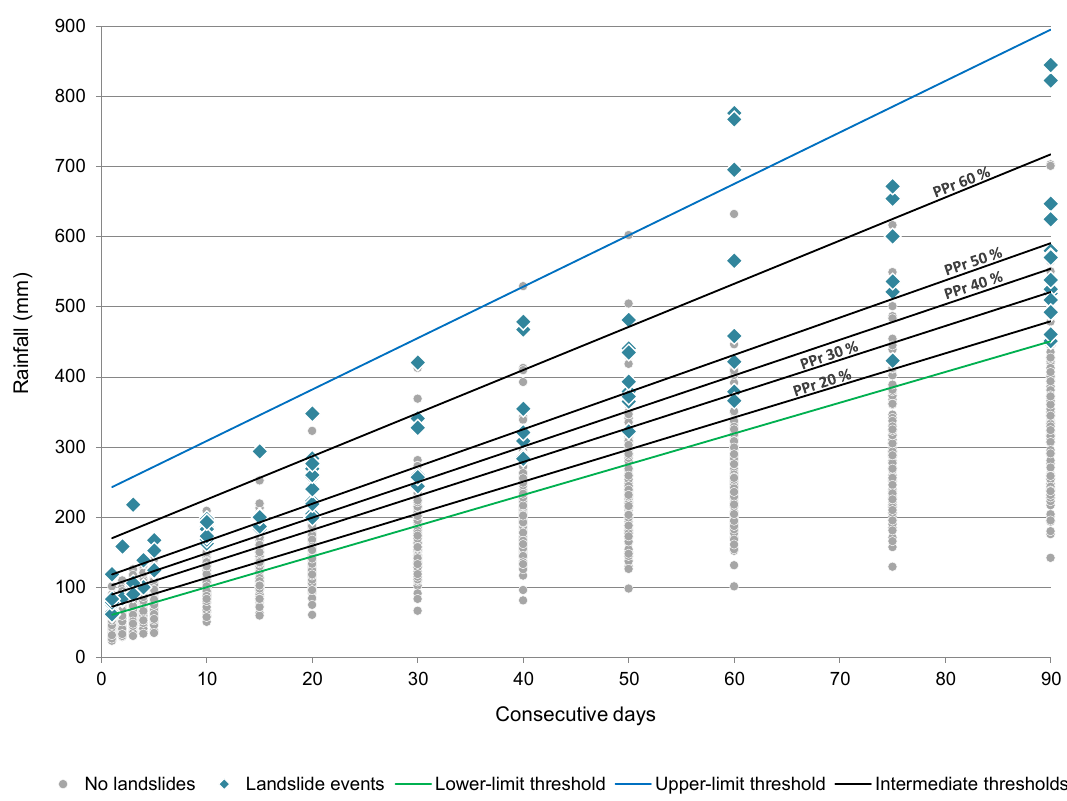
Figure 8. Intermediate thresholds based on the probability of landslide events (20, 30, 40, 50 and 60%) in the zone between the lower-limit threshold and the upper-limit